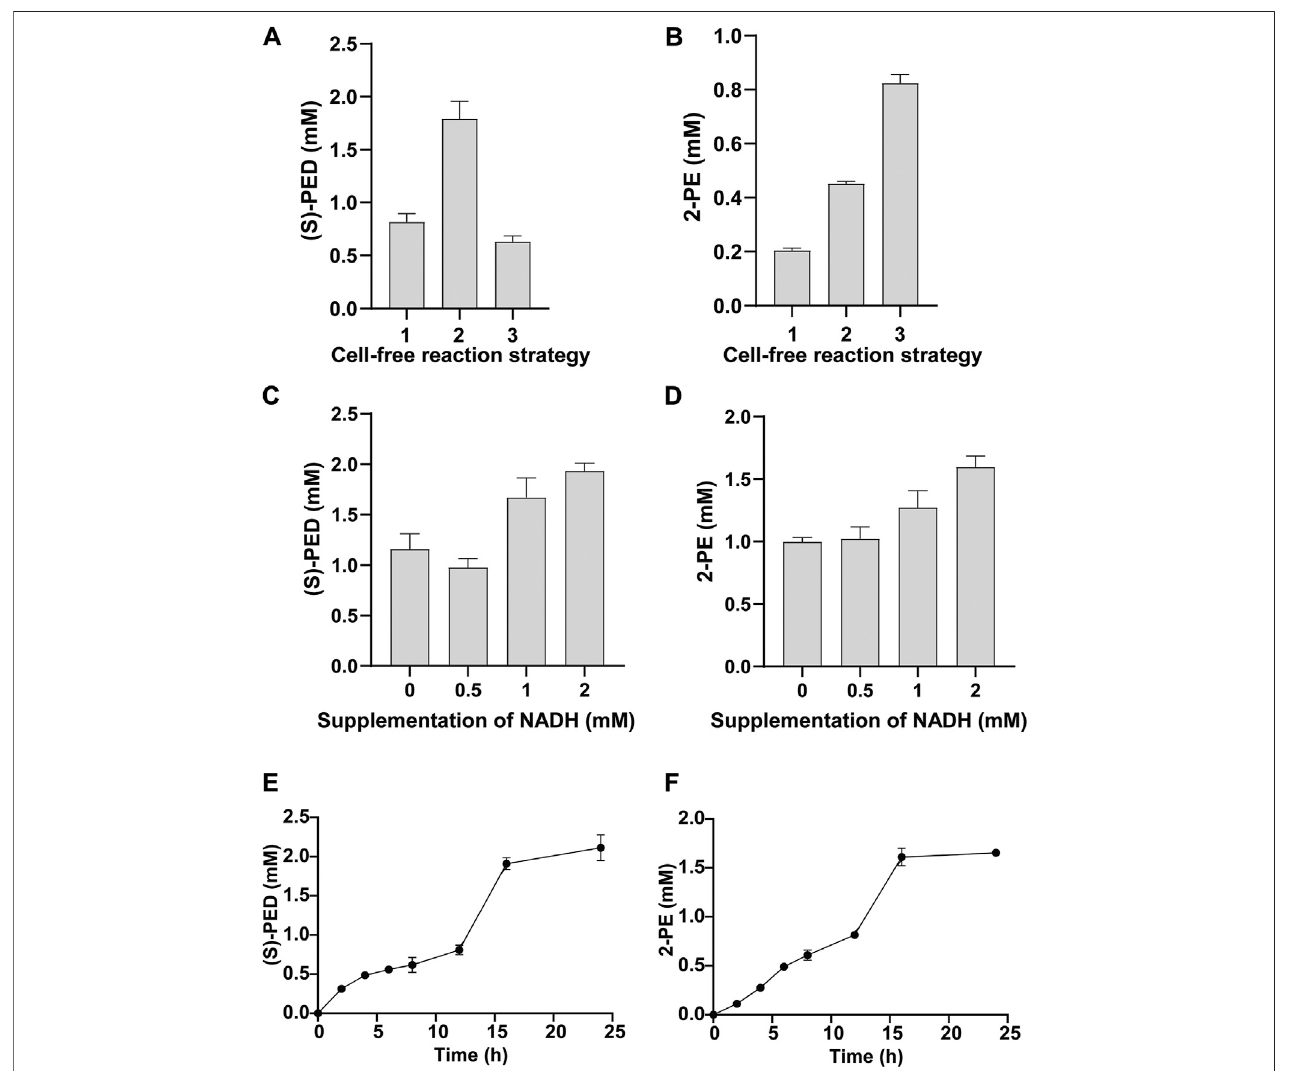
FIGURE6| OptimizationofStyAandStyBexpressionforthesynthesisof (A) ( S )-PEDand (B) 2-PE.Inpanels (A) and (B) :1,bothStyAandStyBwereexpressedin CFPS; 2, StyA was expressed in vivo to prepare cell extracts and StyA-enriched CFPS was used to express StyB; 3, StyA and StyB was fused and the resulting StyA-linker-StyB was expressed in CFPS. Effect of supplementation of NADH on (C) ( S )-PED and (D) 2-PE formation. Time courses of (E) ( S )-PED and (F) 2-PE production within 24 h. Values show means with error bars representing standard deviations (s.d.) of at least three independent experiments.